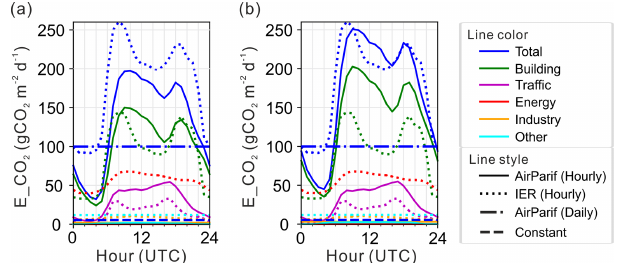
Figure 2. Diurnal profiles (for January) of anthropogenic emissions in the grid cell of the emission map containing the CDS station. Panel (a) is for the 1km grid cell of the AirParif emission inventory that contains the station, whereas panel (b) is the 5km grid cell of the IER inventory around the same station. The local time in Paris is 1h ahead of UTC (UTC + 1) from November to March and 2h ahead of UTC (UTC + 2) from April to